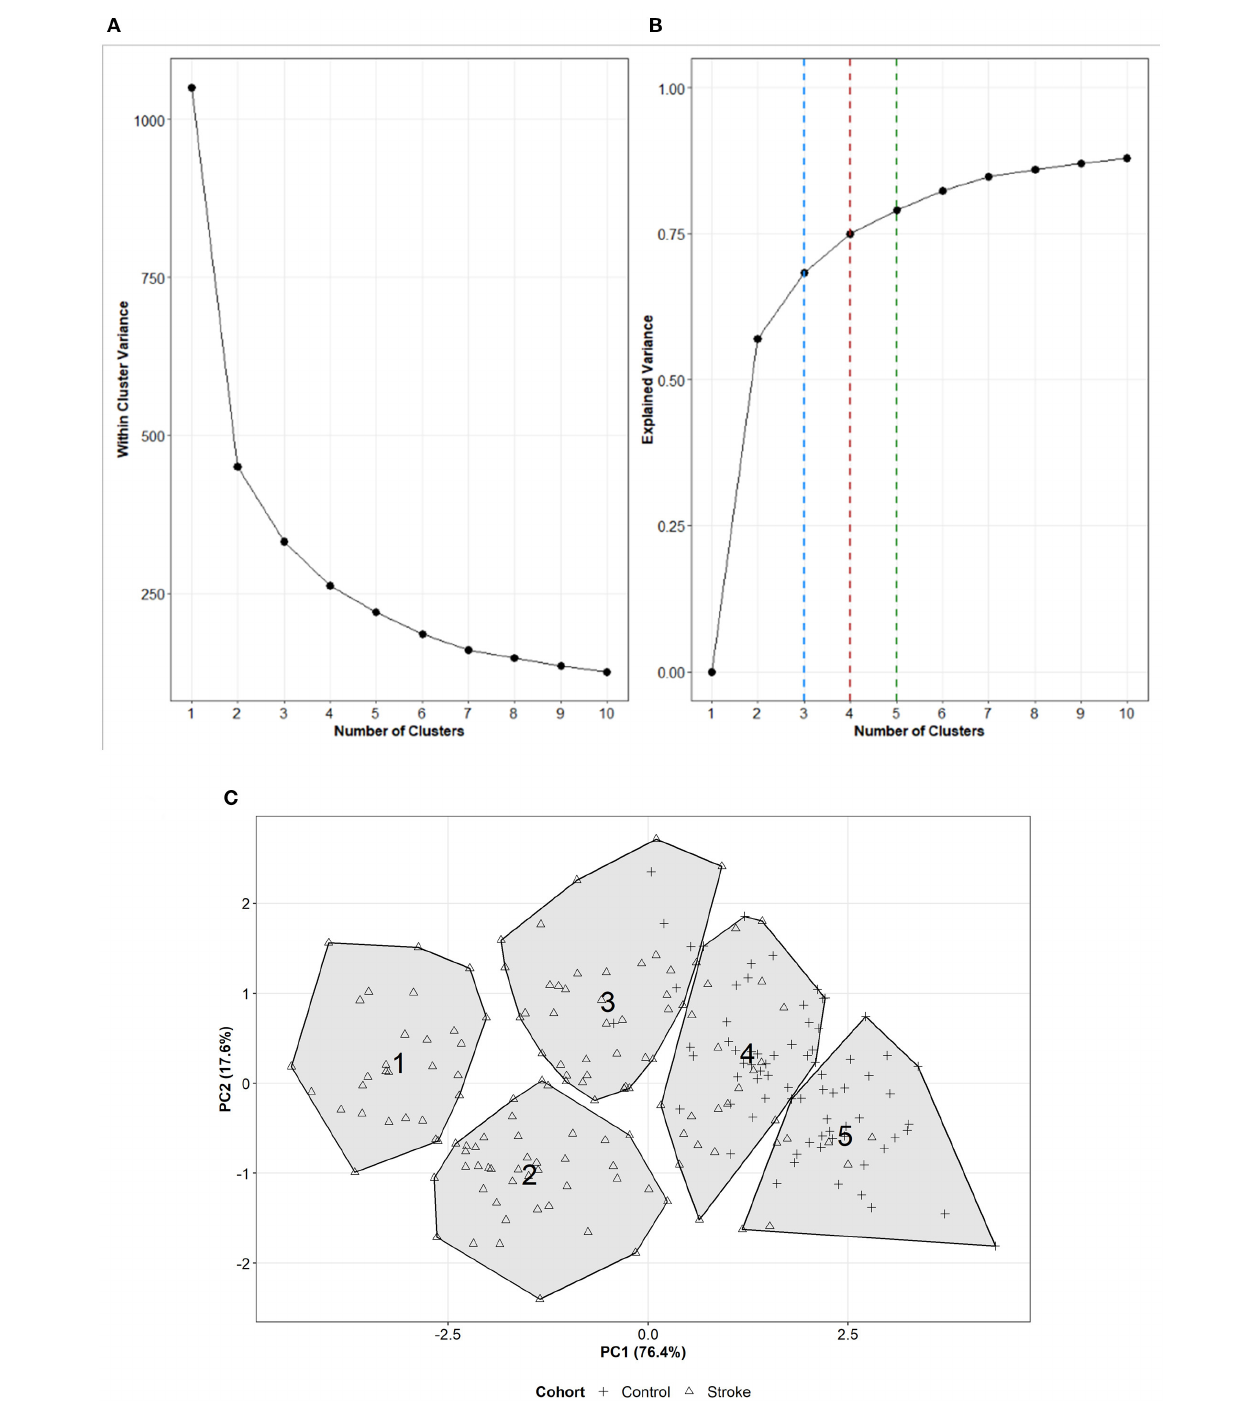
FIGURE 1 | (A) Scree plot representing how the within-cluster variance changes as increasing numbers of clusters are formed with 5 UL performance variables. (B) Line plot representing how the total explained variance changes with increasing numbers of clusters on dataset including 5 UL performance variables. The dashed lines represent the total variance explained for a 3- (blue), 4- (red), or 5- (green) cluster solution. (C) Visual representation of the 5-clusters with 5 UL performance variables across dimension 1 (x-axis) and dimension 2 (y-axis). The cluster number is presented in the location of the centroid of each cluster. The shape of the point within the cluster represents the if a participant was from a stroke (triangle) or control ( + sign) cohort.